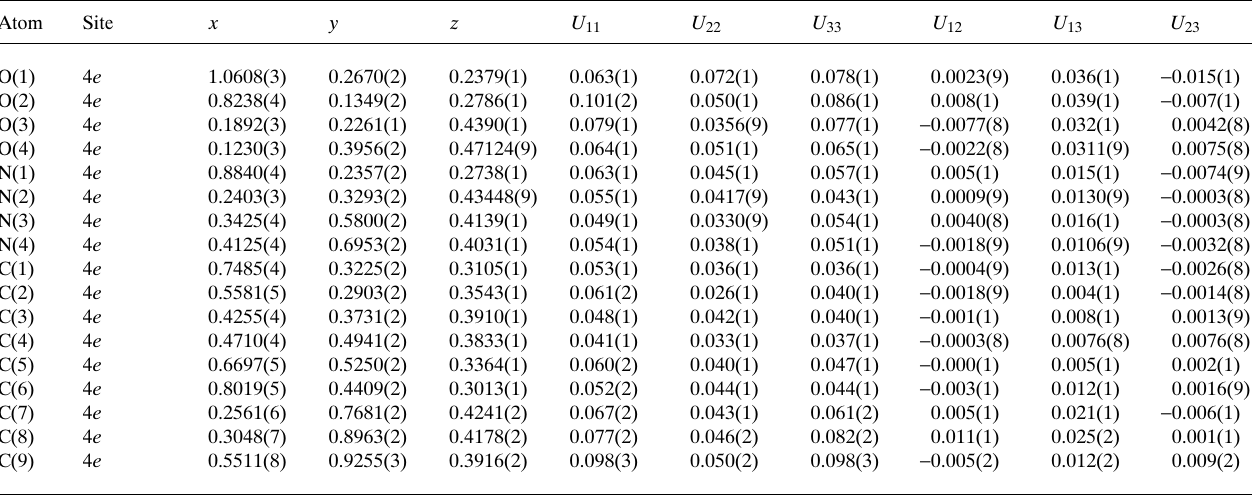
Table 3. Atomic coordinates and displacement parameters (in Å 2 )